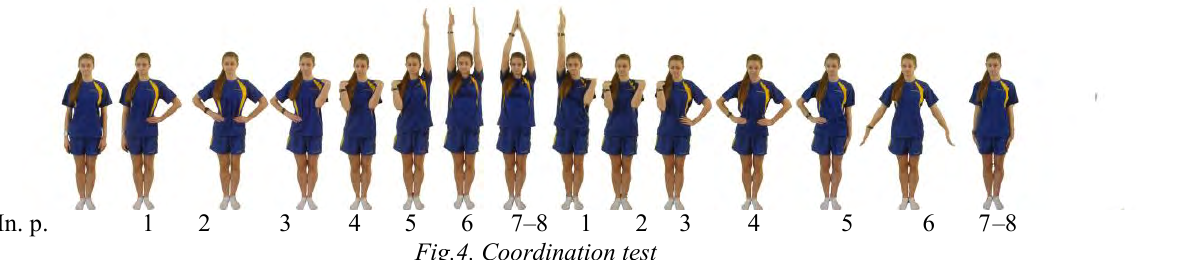
Fig.4. Coordination test